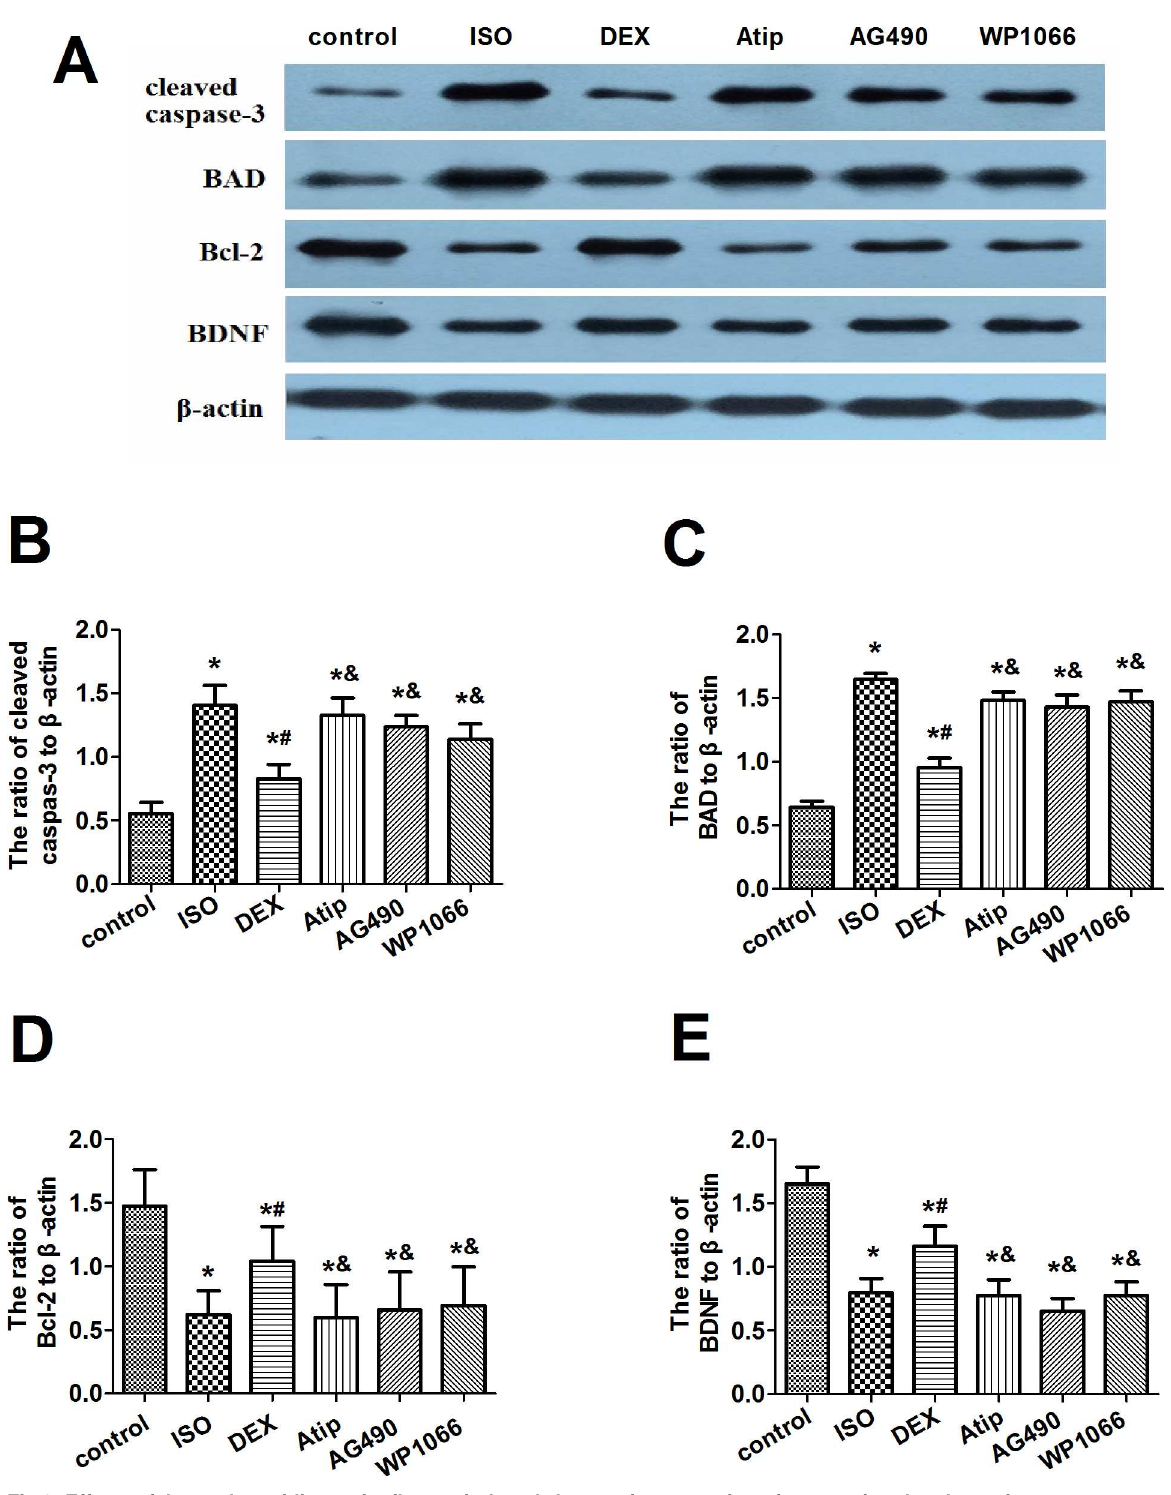
Fig 3. Effects of dexmedetomidine on isoflurane-induced changes in expression of apoptosis-related proteins. Representative Western blots (A) showinglevels of cleaved caspase-3, BAD, Bcl-2 and BDNF in hippocampus at 19d after animals were treated as describedin Fig 2. Levels of caspase-3(B), BAD (C), Bcl-2 (D) and BDNF (E) were quantitated relative to that of β - actin. Data are represented as mean ± SD (n = 8). * P < 0.05 vs. control group; # P < 0.05 vs. ISO group; & P < 0.05 vs. DEX